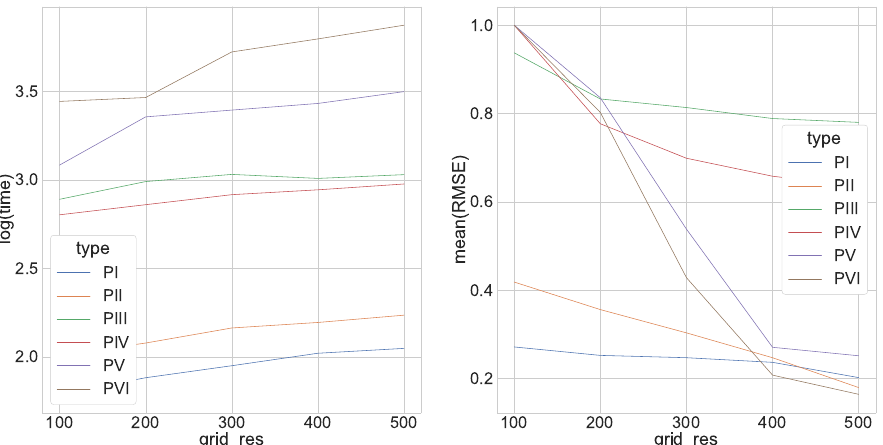
Figure 8. Mean time (in seconds) in the logarithmic scale of the optimization for each Painlevé transcendent ( left ) and mean error ratio ( right ) (1.0 is the maximal error for each equation); the maximal error for PI–PII is at the 10 grid point, which is not